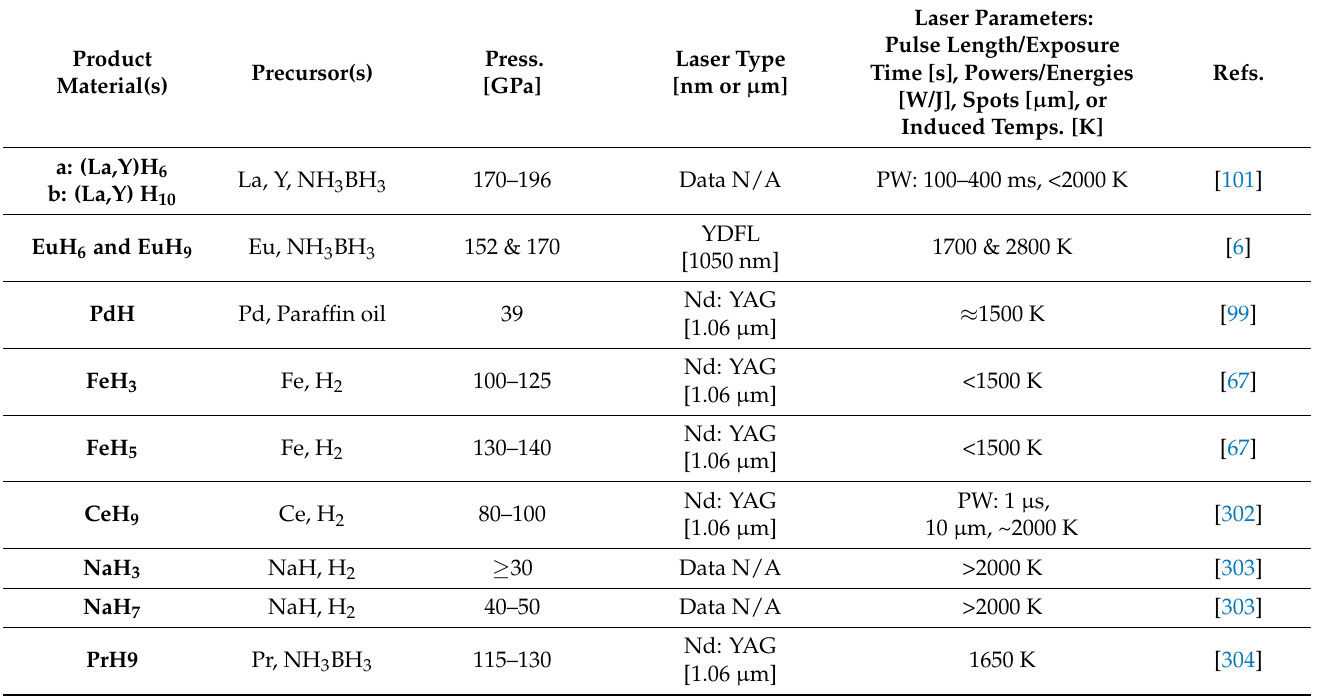
Table 2. Binary Metal Hydrides: Metal Hydrides Synthesised During Selected LRS-DAC